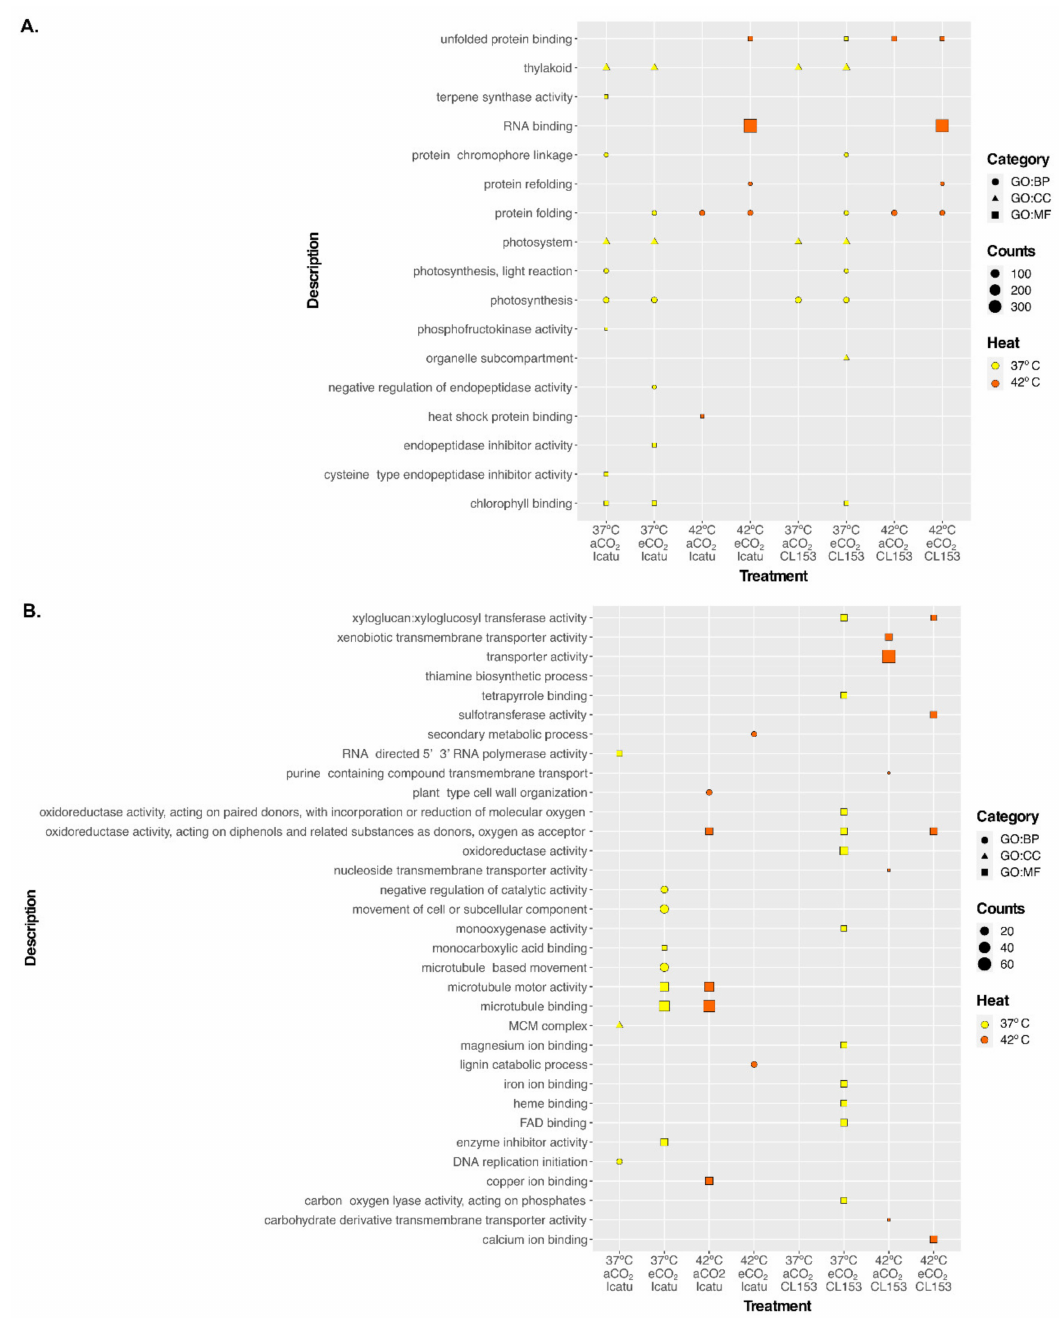
Figure 5. Over-representation analysis of gene ontology (GO) terms performed with gProfiler against the functional annotation of the Coffea canephora genome. Significantly (false discovery rate (FDR) < 0.01) enriched gene ontology (GO) terms among up-regulated ( A ) and down-regulated ( B ) differentially expressed genes (DEGs) in Icatu and CL153 were ranked by increasing log 2 fold change (FC), considering the effect of supra-optimal temperatures at 37/28 ◦ C (37 ◦ C), and 42/30 ◦ C (42 ◦ C) in plants grown in 380 µ L L − 1 aCO 2 or 700 µ L L − 1 eCO 2 . The absence of a treatment in the figure indicates that no enriched GO terms were found. GO terms are grouped by the main categories: biological process (GO:BP), molecular function (GO:MF), and cellular component (GO:CC). Counts indicate the number of DEGs annotated with each GO term and dots are colored by temperature